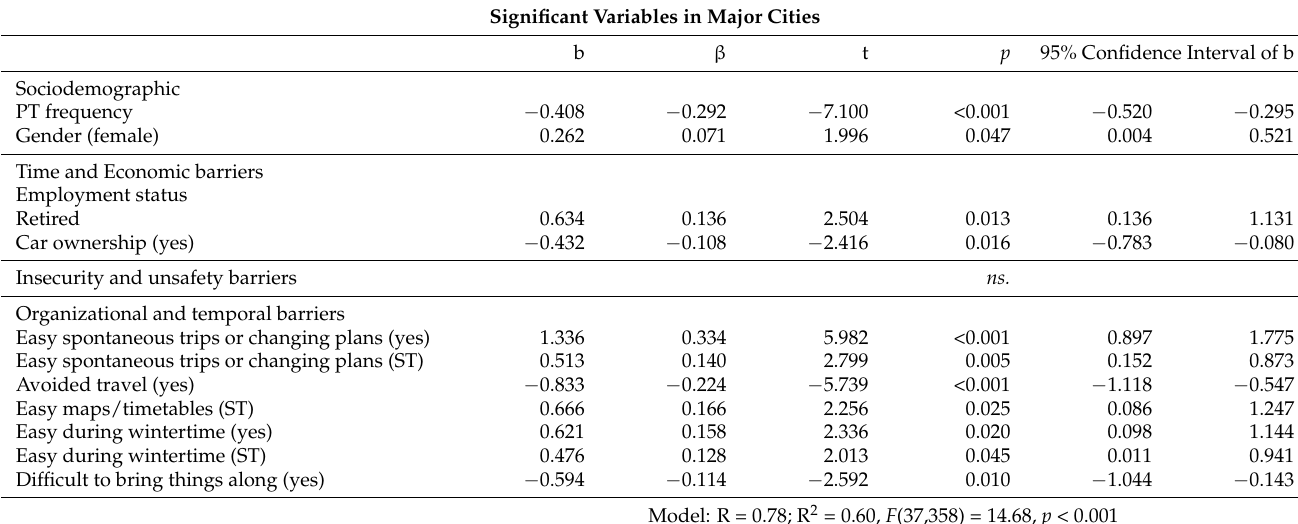
Table 2. Significant variables in the regression analysis of perceived accessibility of public transport in major cities ( N = 453).